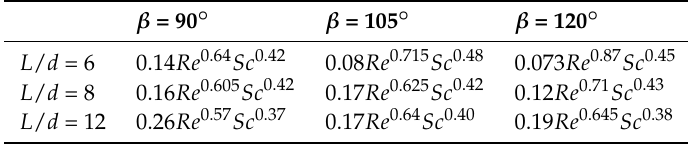
Table 3. Correlation for Sh calculation considering different FSGs